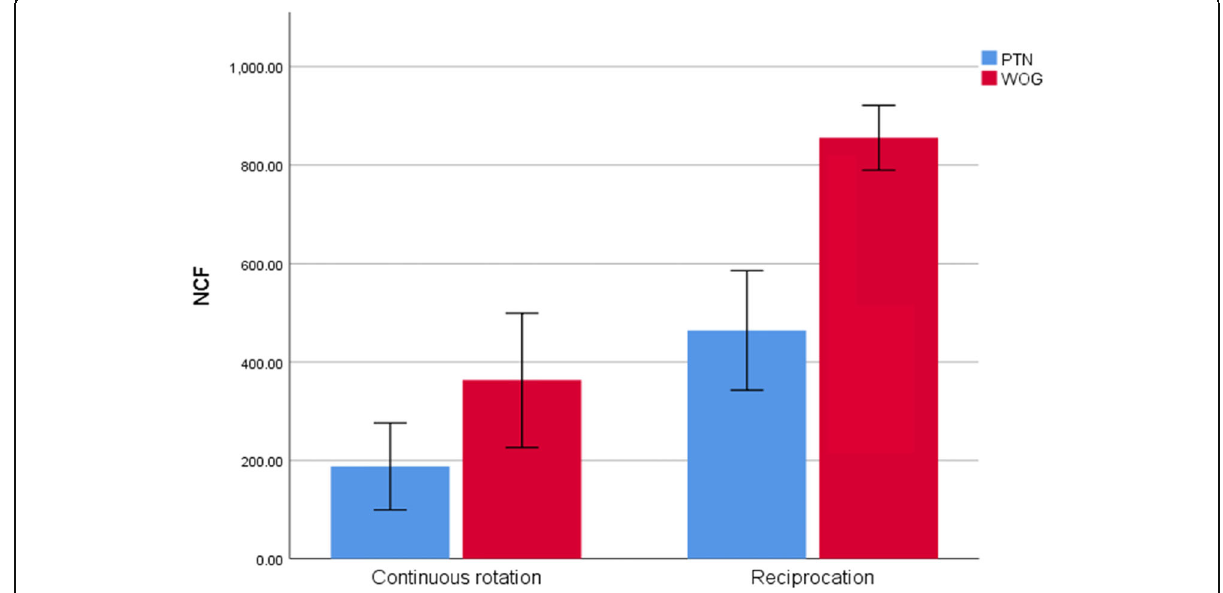
Fig. 3 Bar chart showing mean and standard deviation values of number of cycles till fracture (NCF) in different